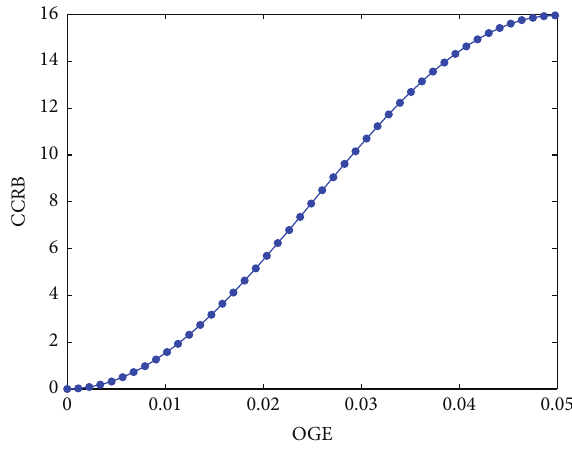
Figure 4: MSE increases with the